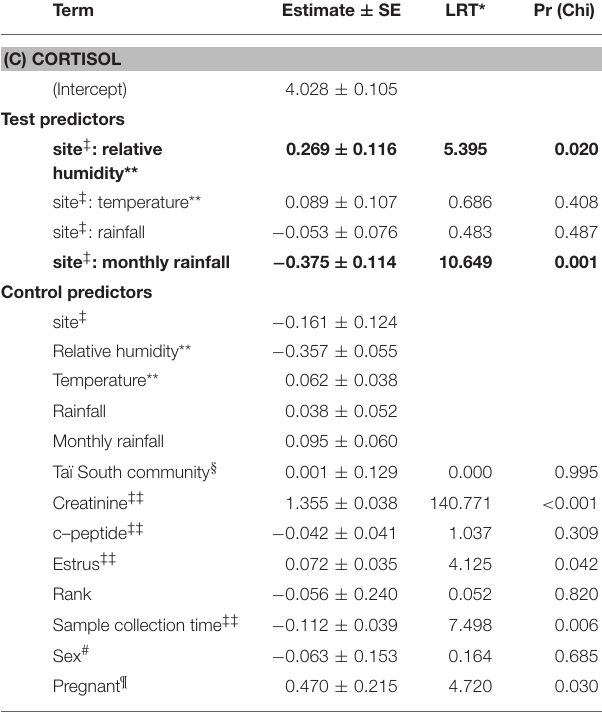
Sample sizes for respective models for urinary (A) creatinine, (B) c-peptide, and (C) cortisol levels are 438, 431, and 498, respectively; number of individuals included in the models is 40. Statistically significant results (p ≤ 0.05) appear in bold. * Degrees of Freedom is one for all three